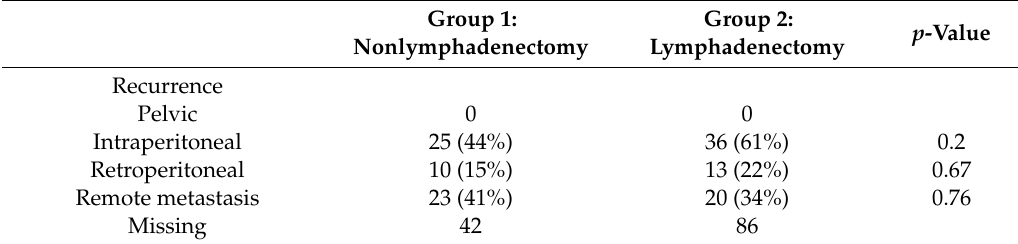
Table 6. Recurrence